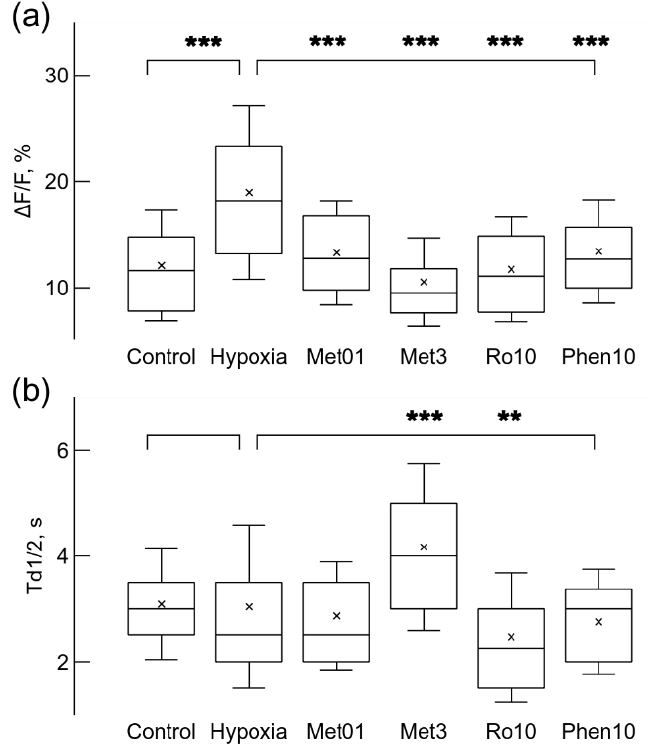
Figure 5. Hypoxia and drugs applied before hypoxic condition changed Ca 2+ signal relative ampli- tude, ∆ F/F ( a ), and the time of decay to half-amplitude, Td1/2 ( b ). Hypoxia increased the relative strength of Ca 2+ signals ( a ), while application of 0.1 mM metformin (Met01), 3 mM (Met3) metformin, 10 nM rotenone (Ro10), or 10 µ M (Phe10) phenformin reduced the strength when applied separately before growth under mild hypoxic conditions. Only 3 mM metformin significantly increased the time of decay to half-amplitude Td1/2, and 10 nM rotenone reduced it ( b ). ** p < 0.01, *** p < 0.001 (Welch’s t